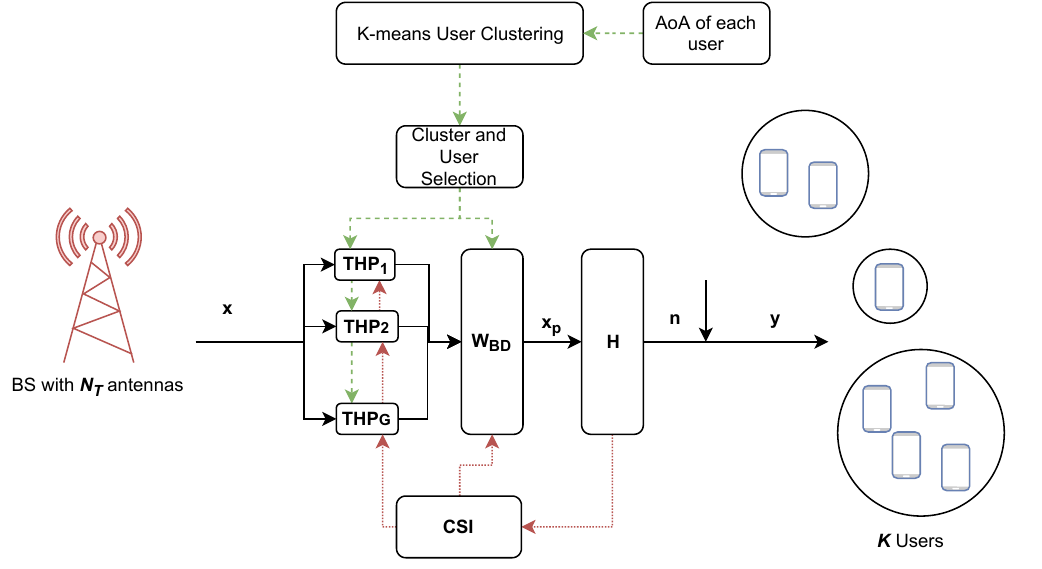
Figure 7. Hybrid precoding with user